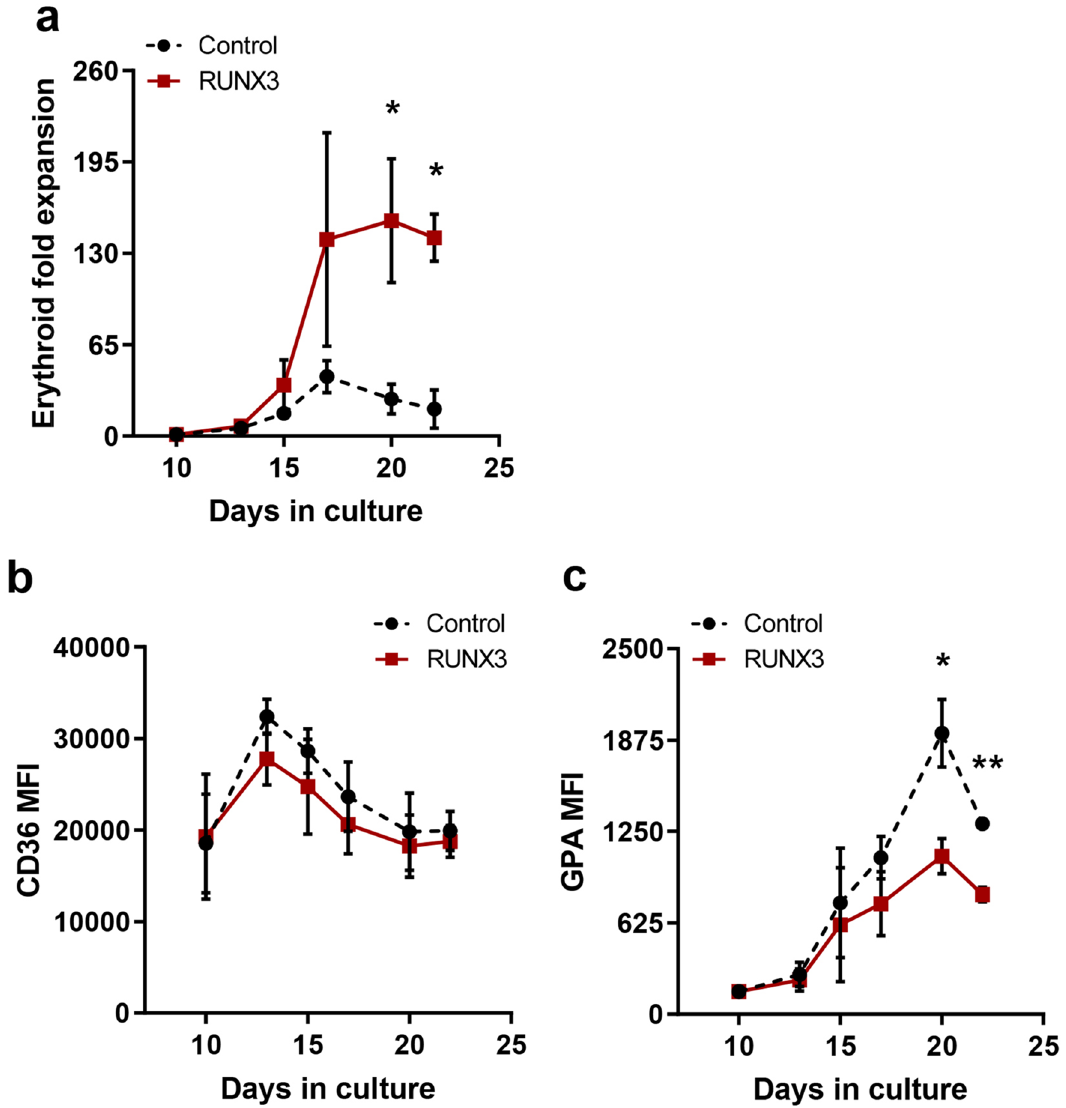
Figure 3. RUNX3 overexpression promotes proliferation and supresses GPA expression during the EPO dependent phase of differentiation. ( a ) Cumulative fold expansion of CD13 low CD36 high erythroid committed cells during the EPO dependent phase of growth. HSPC were initially cultured with IL-3, IL-6 and SCF for 10 days followed by addition of EPO at day 10. ( b ) Summary data of CD36 and ( c ) GPA MFI in CD13 low CD36 high erythroid committed cells over time. Data indicate mean ± 1SD (≥ 4). Significant difference of RUNX3-expressing cells from controls was analysed by paired t-test, * p < 0.05, ** p <